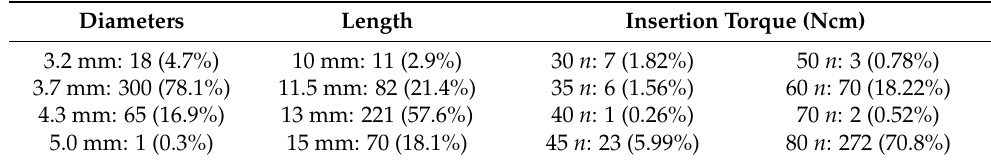
Table 1. Implants characteristics and torque